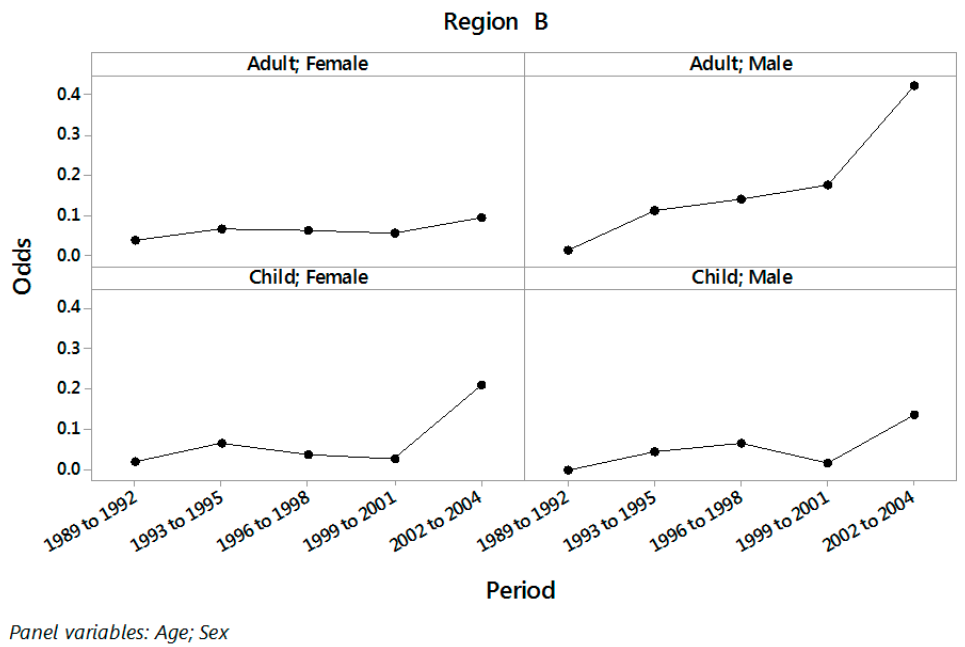
Figure 2. Odds of PH in periods from 1989 to 1992, 1993 to 1995, 1996 to 1998, 1999 to 2001 and 2002 to 2004 for each combination of age and sex in Region B.